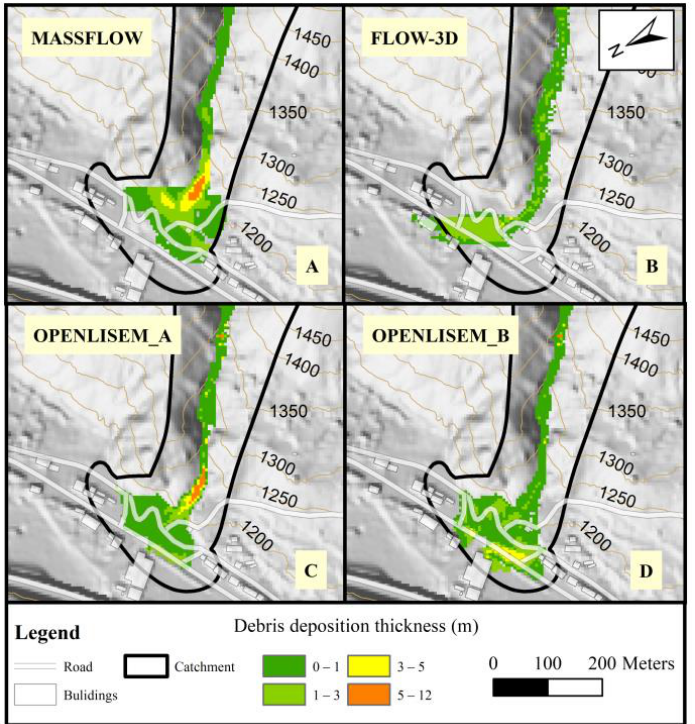
Figure 13. The prediction results without mitigation structures. Simulations for Massflow ( A ), Flow-3D ( B ), OpenLISEM_A ( C ), and OpenLISEM_B ( D ).